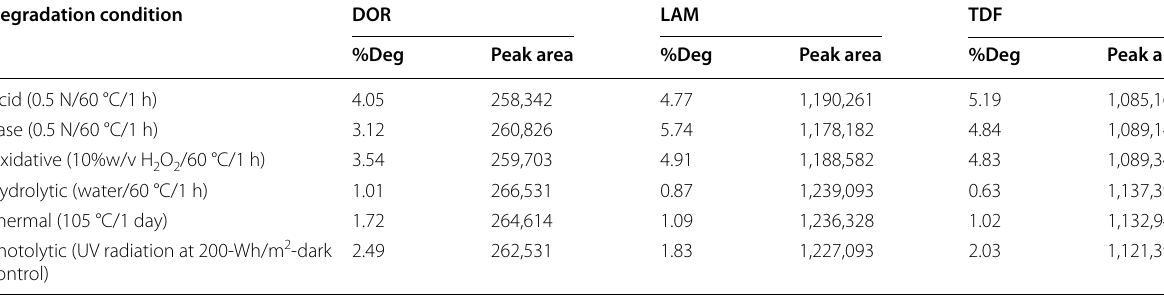
DOR Doravirine, LAM Lamivudine, TDF Tenofovir disoproxil fumarate, h hours, % percentage, UV ultraviolet, min minute, N normality, °C degree celsius, Wh/m 2 watt- hour per square metre, % Deg percentage degradation